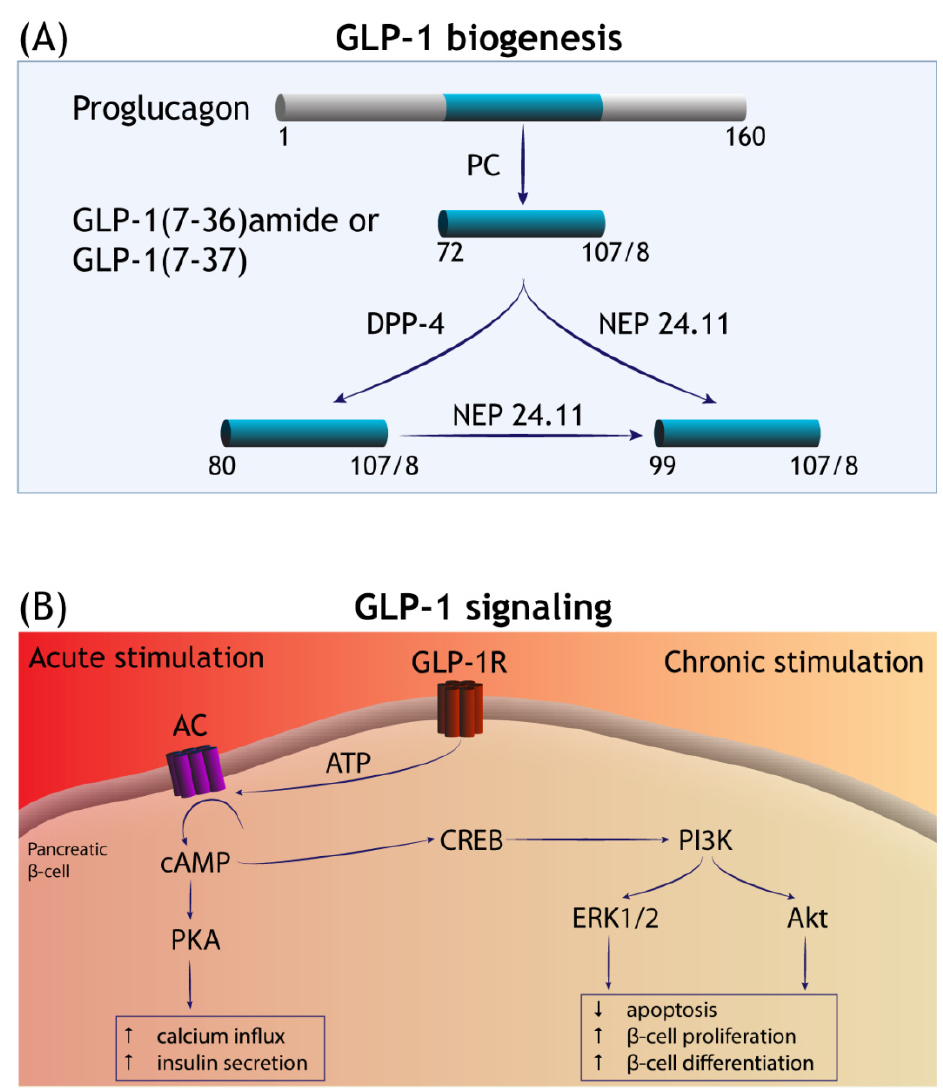
Figure 1. GLP-1 biogenesis and signalling transduction. ( A ) GLP-1 is liberated from the precursor molecule proglucagon—in the enteroendocrine L cells and in the CNS—by the isoforms of pro- hormone convertase (PC). GLP-1 (7–36)-amide and GLP-1 (7–37) are the major bioactive forms in circulation and degraded by the serine protease dipeptidyl peptidase (DPP-4) and neutral endopep- tidase 24.11 (NEP 24.11). ( B ) The acute phase of GLP-1 receptor (GLP-1R) stimulation involves the activation of adenylate cyclase (AC) and a rise in the levels of intracellular cyclic (AMP), with subsequent engagement of additional effector mechanisms mediated by protein kinase A (PKA). This culminates in increased calcium influx and the promotion of insulin secretion by the islet β - cells. Long-term (chronic) stimulation of GLP-1R is thought to occur via cAMP-responsive element binding (CREB) signalling that promotes pro-survival gene expression mediated by the receptor tyrosine kinases PI3K/Akt and extracellular signal-regulated kinase (ERK)1/2, among others (see Introduction). In the pancreas, this increases β -cell mass by diminishing apoptosis and increasing β -cell proliferation and